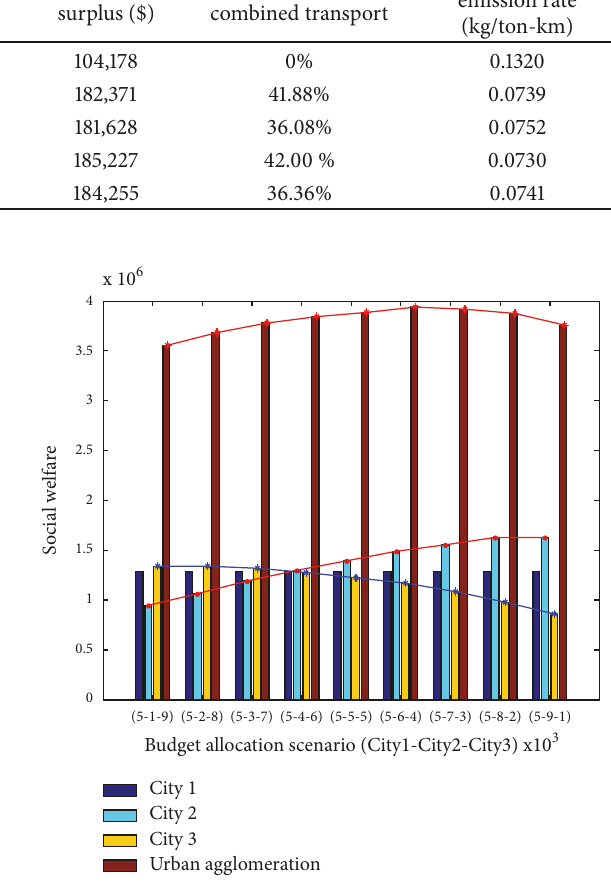
Figure 6: Social welfare for each city under different budget